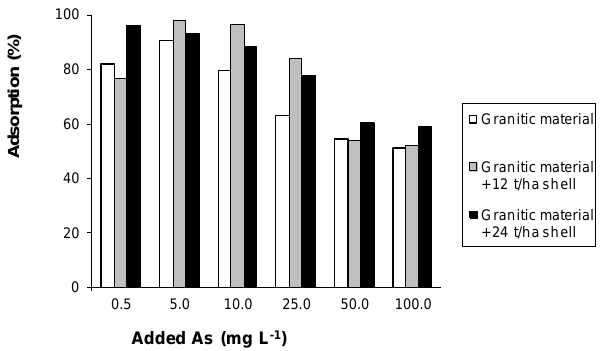
Figure 2. Relationship between added As(V) (mgL − 1 ) and As(V) percentage adsorption for the unamended and shell-amended (12 or 24tha − 1 ) granitic material. Average values for three replicates, with coefficients of variation always < 5%.